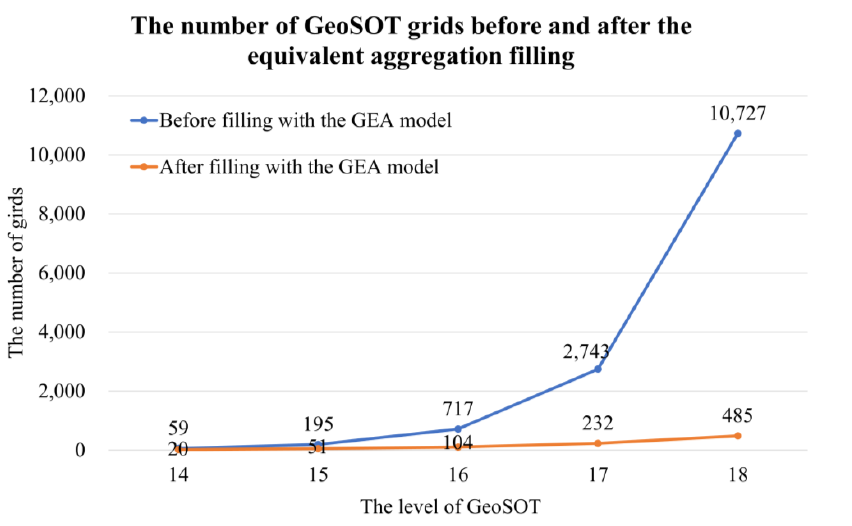
Figure 14. The comparison of the number of GeoSOT grids before and after the equivalent aggrega- tion